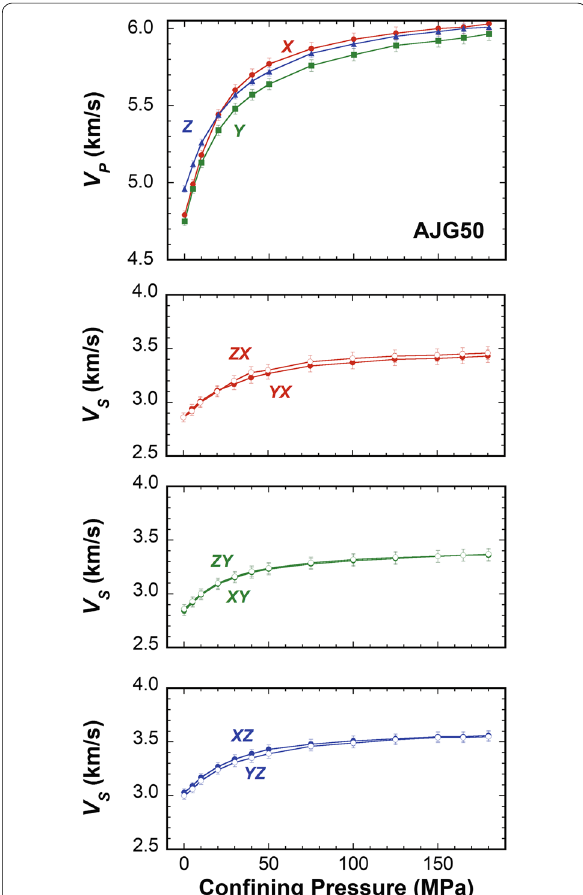
Fig. 3 Compressional and shear wave velocities in a dry rock sample AJG50 are shown as a function of confining pressure. The letter beside a compressional wave velocity represents the propagation direction. The first letter beside a shear wave velocity is the oscillation direction and the second letter the propagation direction. Z -direction is parallel to the axis of the cylindrical sample. X - and Y -directions are perpendicular to Z -direction and mutually orthogonal